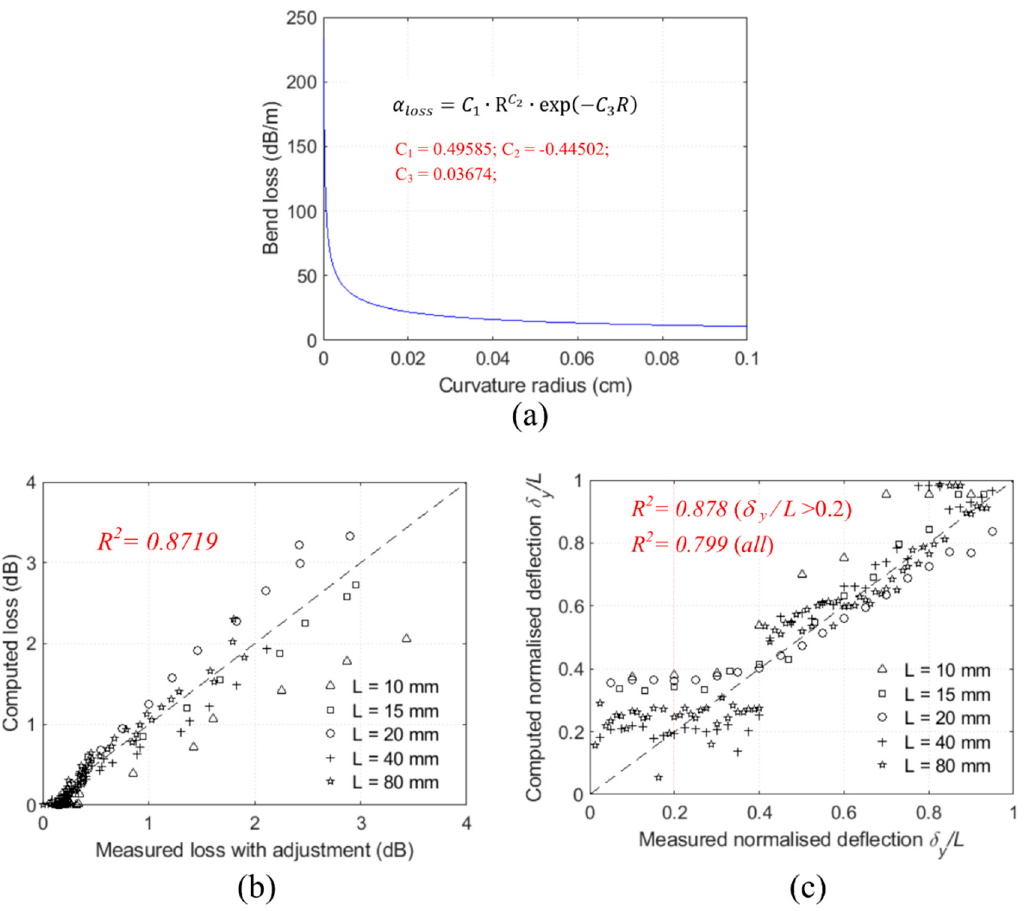
Figure 8. ( a ) The bend loss vs curvature radius relationship and the comparisons of the computed with the measured ( b ) loss and ( c ) normalised deflections.